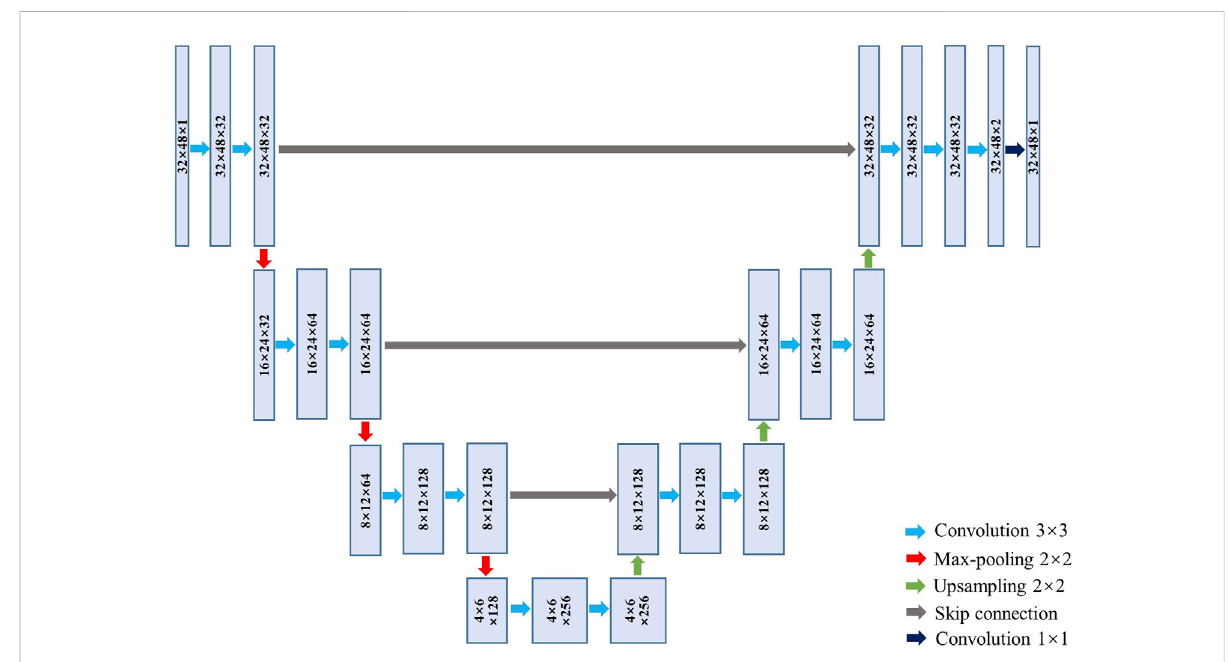
FIGURE 2 Architecture of U-net. The left side of the U-shape is the downsampling side and the right side is the upsampling